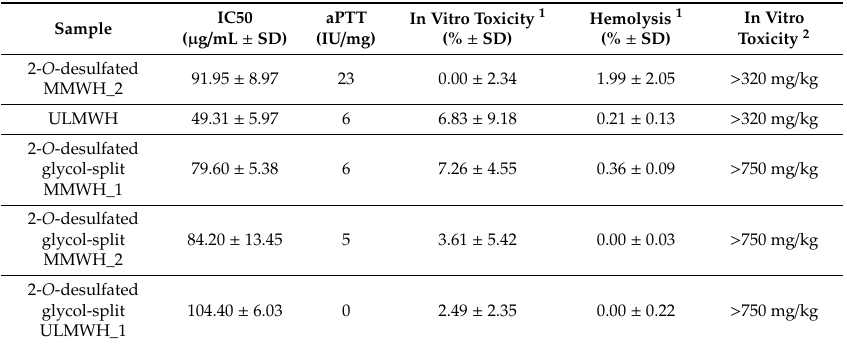
Table 4. Compilation of relevant data for heparin samples to be used in vivo.